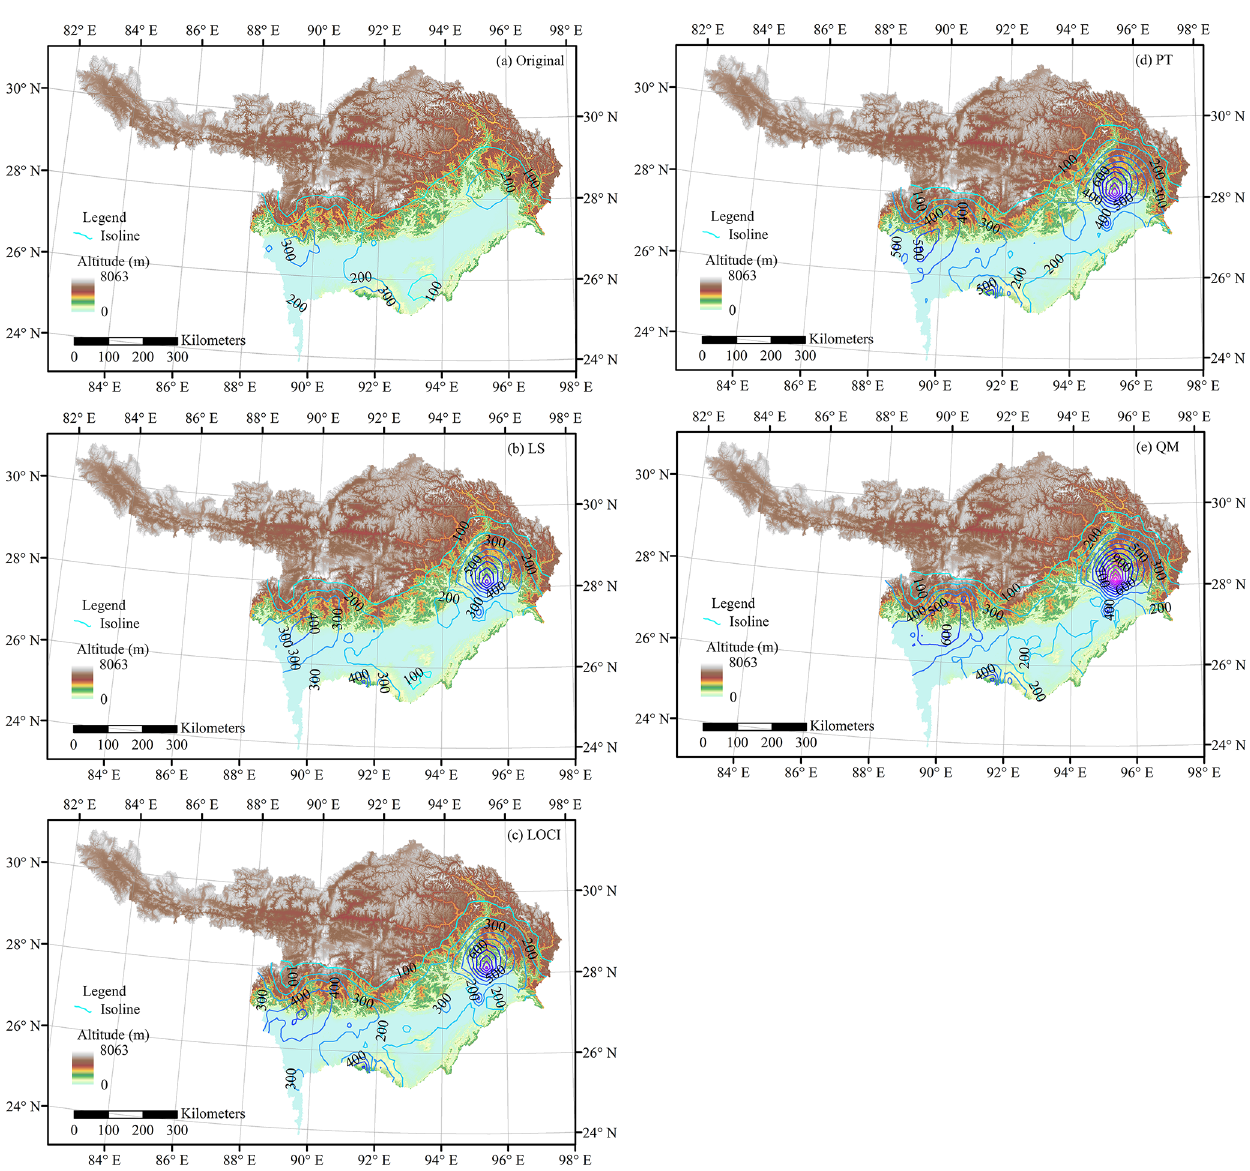
Figure 6. Spatial distribution of mean Rx5d during JJAS in the YBRB based on (a) the original APHRODITE estimates, (b) linear scal- ing (LS)-APHRODITE estimates, (c) local intensity scaling (LOCI)-APHRODITE estimates, (d) power transformation (PT)-APHRODITE estimates, and (e) quantile–quantile mapping (QM)-APHRODITE